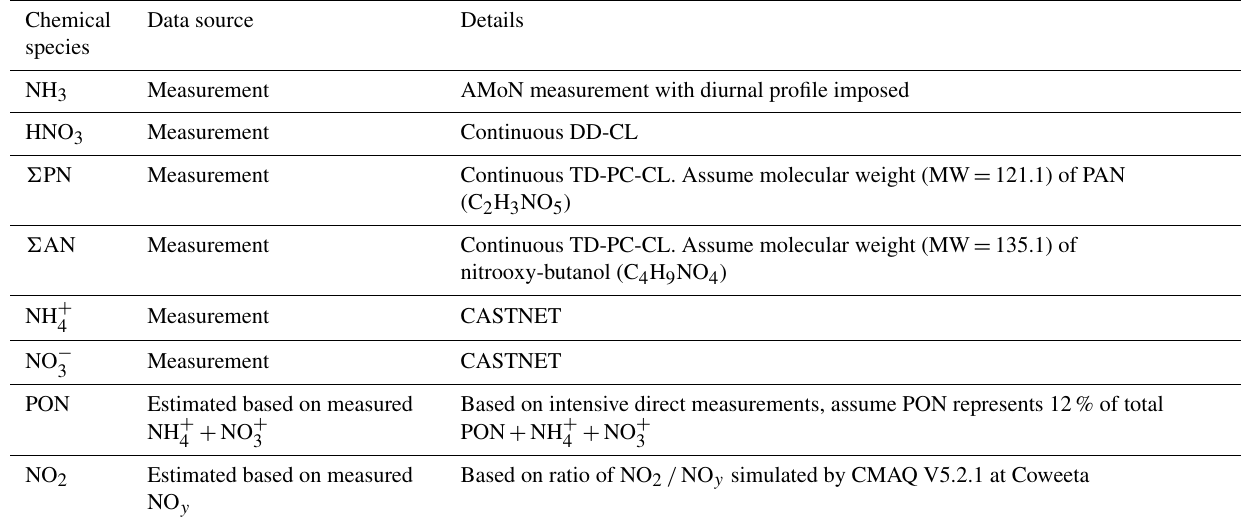
Table 3. Summary of air concentration data sources for STAGE dry deposition modeling. Chemical Data source Details species Measurement AMoN measurement with diurnal profile imposed Continuous DD-CL Continuous TD-PC-CL. Assume molecular weight (MW = 121.1) of